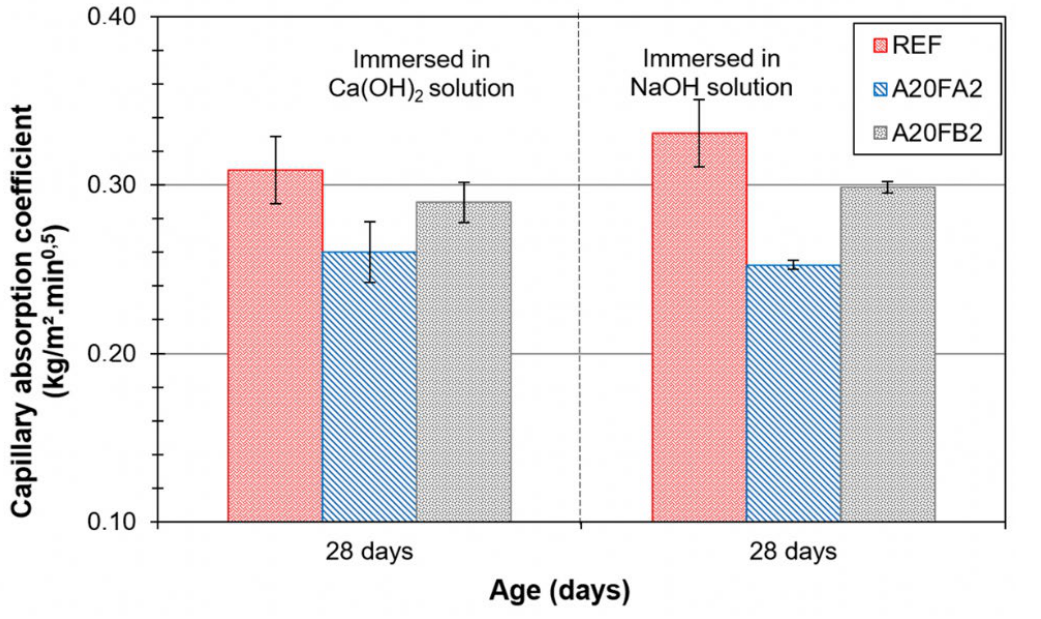
Figure 9. Capillary absorption coefficients of the reference mortars and those containing 20% of GRF at 28 days immersed in saturated solution in lime and at 28 days immersed in solution of NaOH